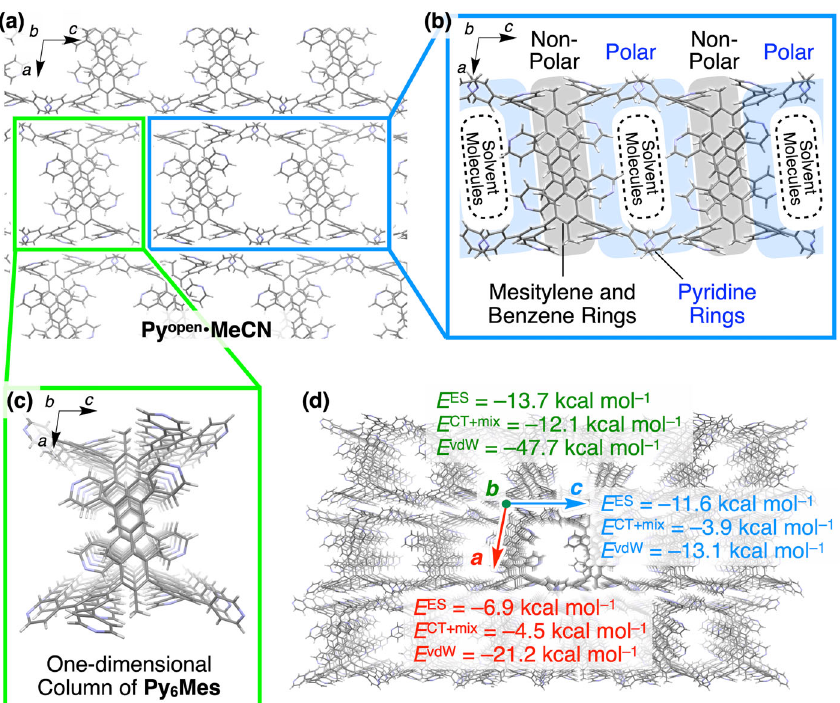
Fig. 2 Computational analysis of the attractive and repulsive energies in Py open ·MeCN. a A crystal packing diagram of Py open ·MeCN viewed along the crystallographic b -axis. b A partial crystal packing of Py open ·MeCN highlighting the polar shell and nonpolar core. c A columnar stacking of Py 6 Mes in Py open ·MeCN . d Electrostatic energy ( E ES ), charge transfer energy with higher-order mixed terms energies ( E CT + mix ), and dispersion energy ( E vdW ) exserted along the crystallographic a - (red), b- (green), and c- axes (blue) in Py open ·MeCN